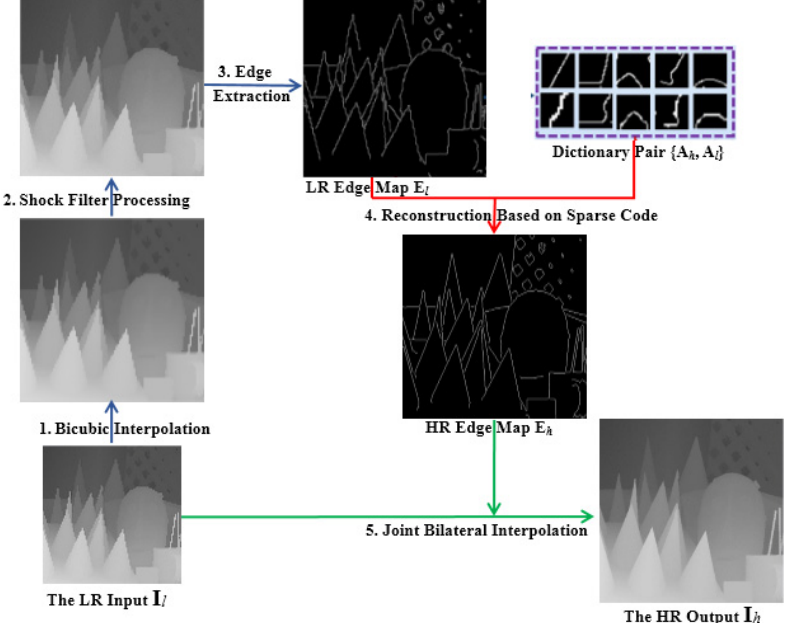
Figure 1. Pipeline of the edge ‐ guided depth image SR.